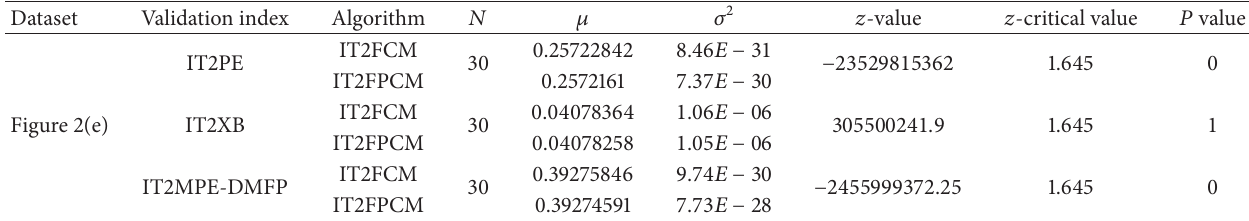
Table 44: Statistical test for the IT2PE, IT2XB, and IT2MPE-DMFP indices of validation for Figure 2(e) clustering.